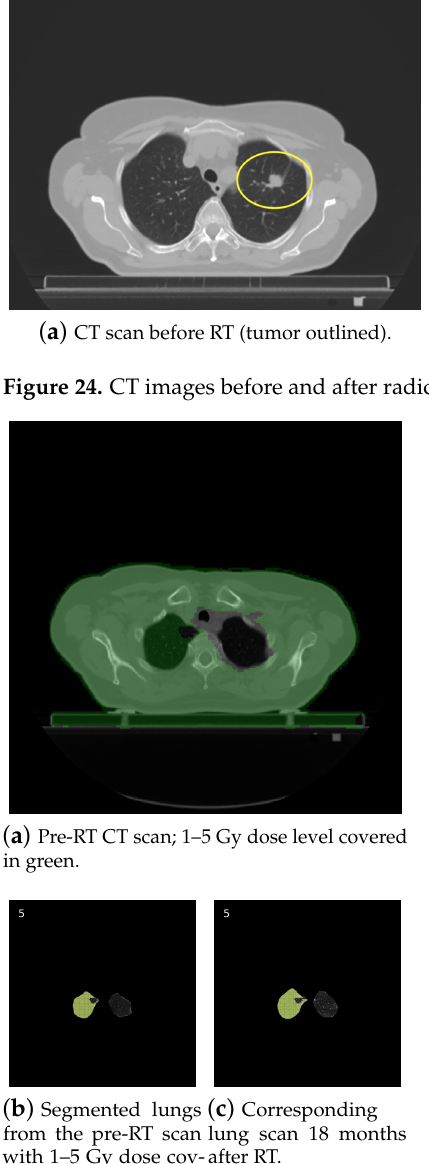
Figure 25. CT images before and after radical RT of left lung